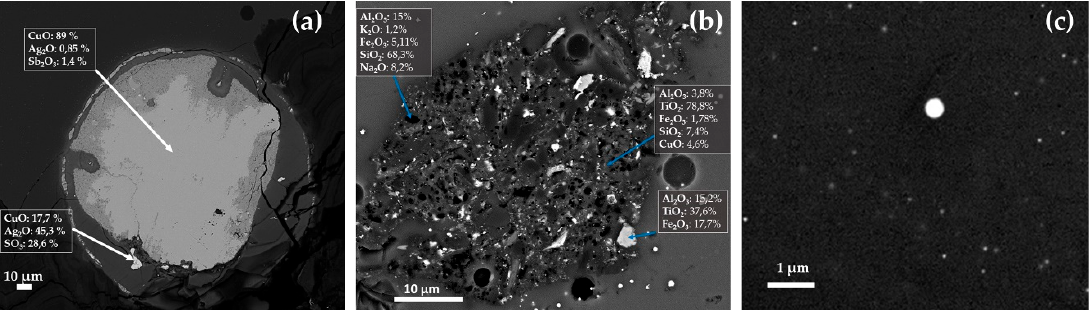
Figure 23 . FEG–SEM micrographs of R16, R10 and R1 samples. Inclusion rich in Ag in R16 ( a ); probable